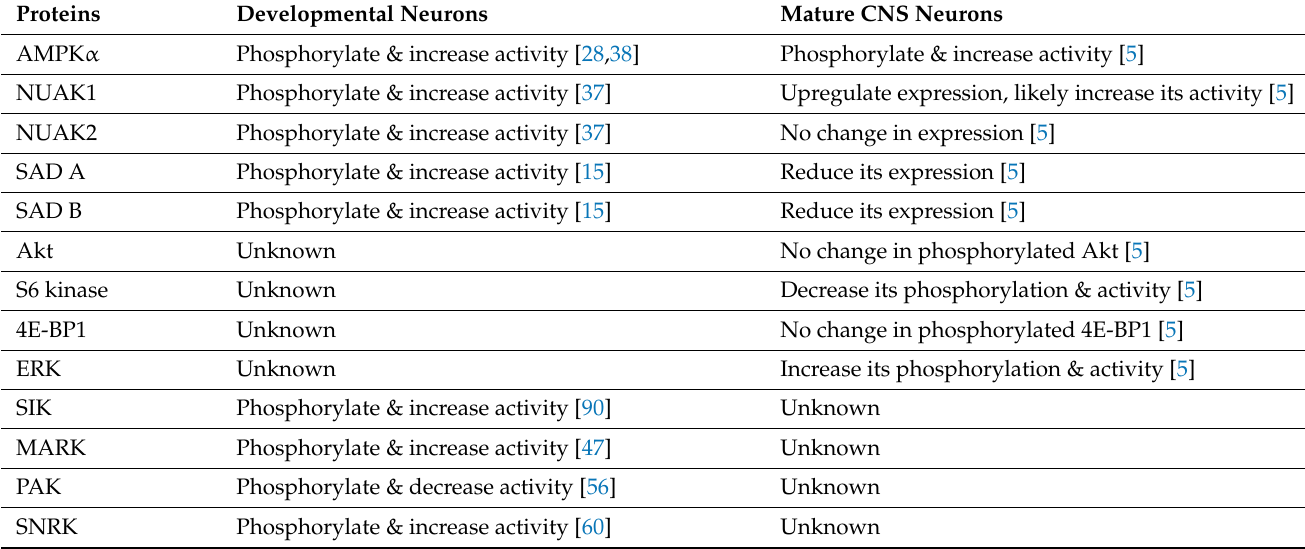
Table 1. The effects of LKB1 on several downstream signaling proteins in developmental and mature